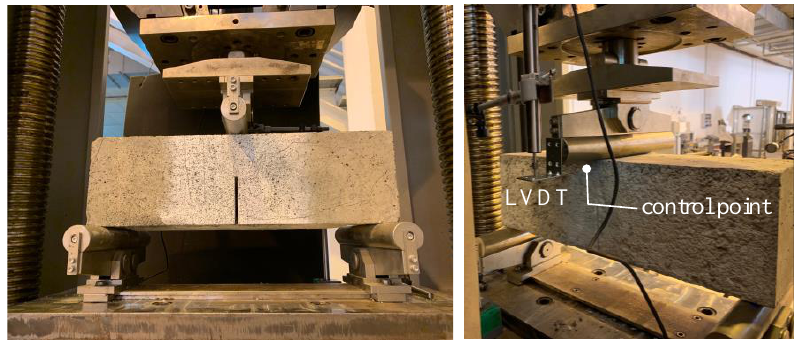
Figure 5. Schematic representation of the Digital Image Correlation (DIC) measuring process.